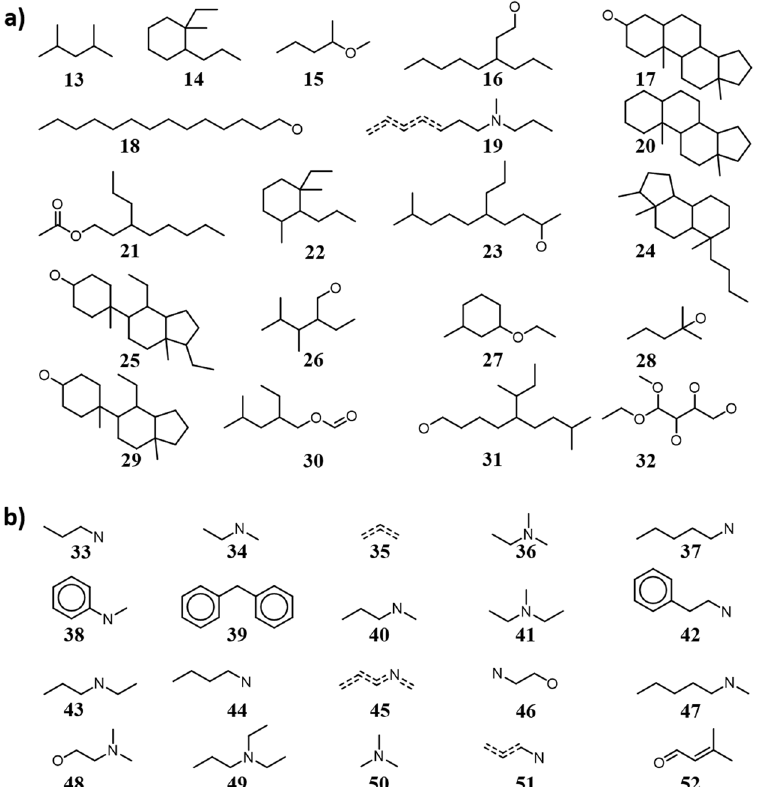
Figure 7. Top-20 MCS chemical “keywords” characteristic of ( a ) natural products and ( b )